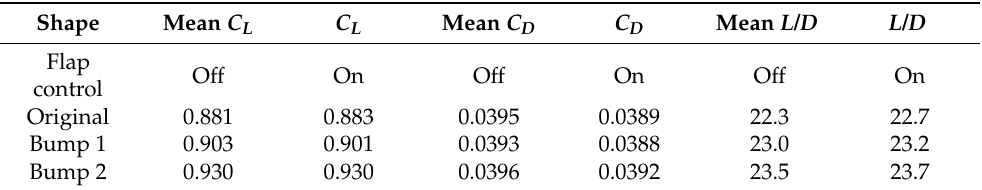
Table 4. Aerodynamic performances of different configurations with and without the closed-loop flap control.